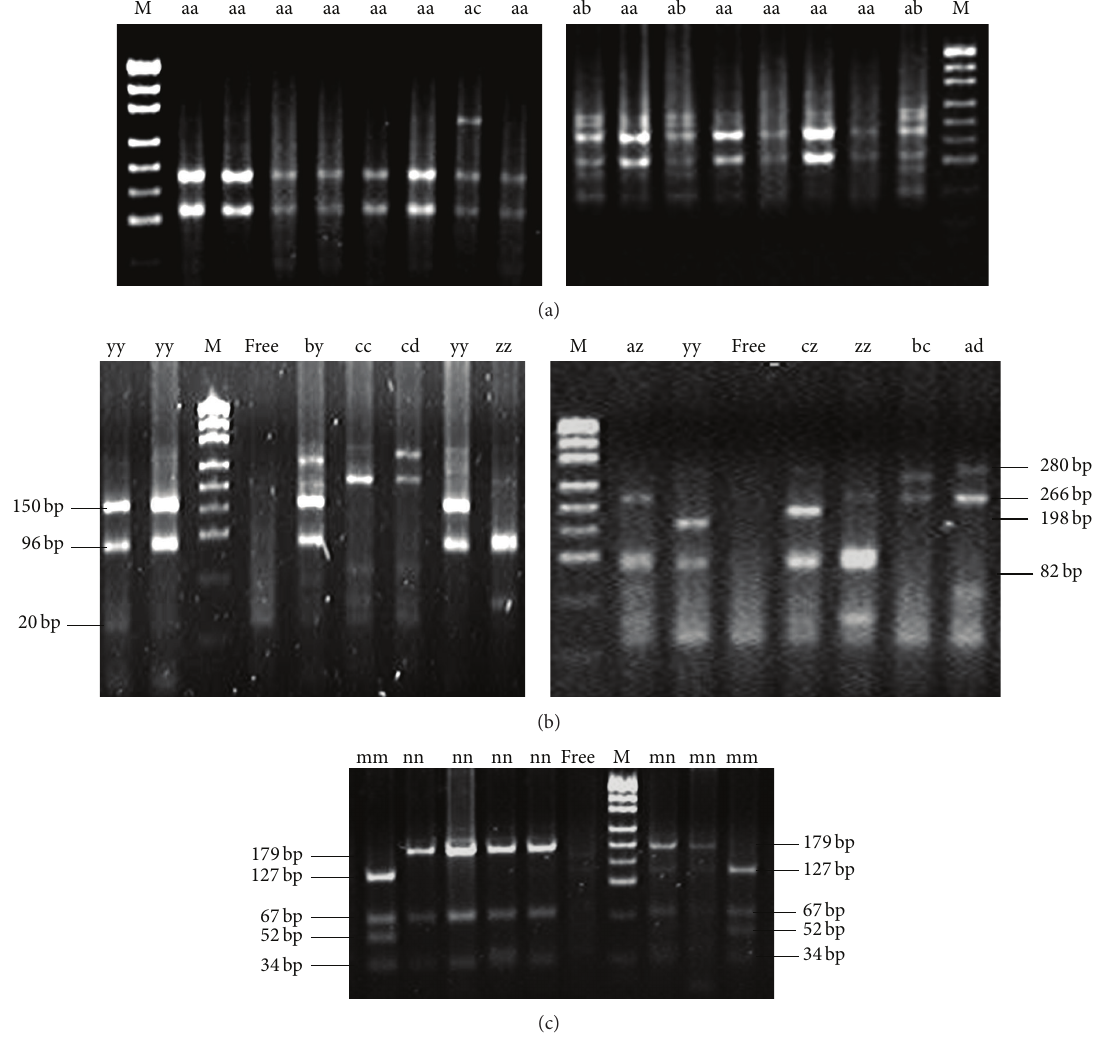
Figure 2: (a) Part results of electrophoretic patterns of exon 2 of MHC-DQB1 digested with TaqI in Chinese Merino sheep; M: pUC19 DNA marker. (b) Part results of electrophoretic patterns of exon 2 of MHC-DQB1. (c) Part results of electrophoretic patterns of exon 2 of MHC- DQB1 digested with Hae III in Chinese Merino sheep; M: pUC19 DNA